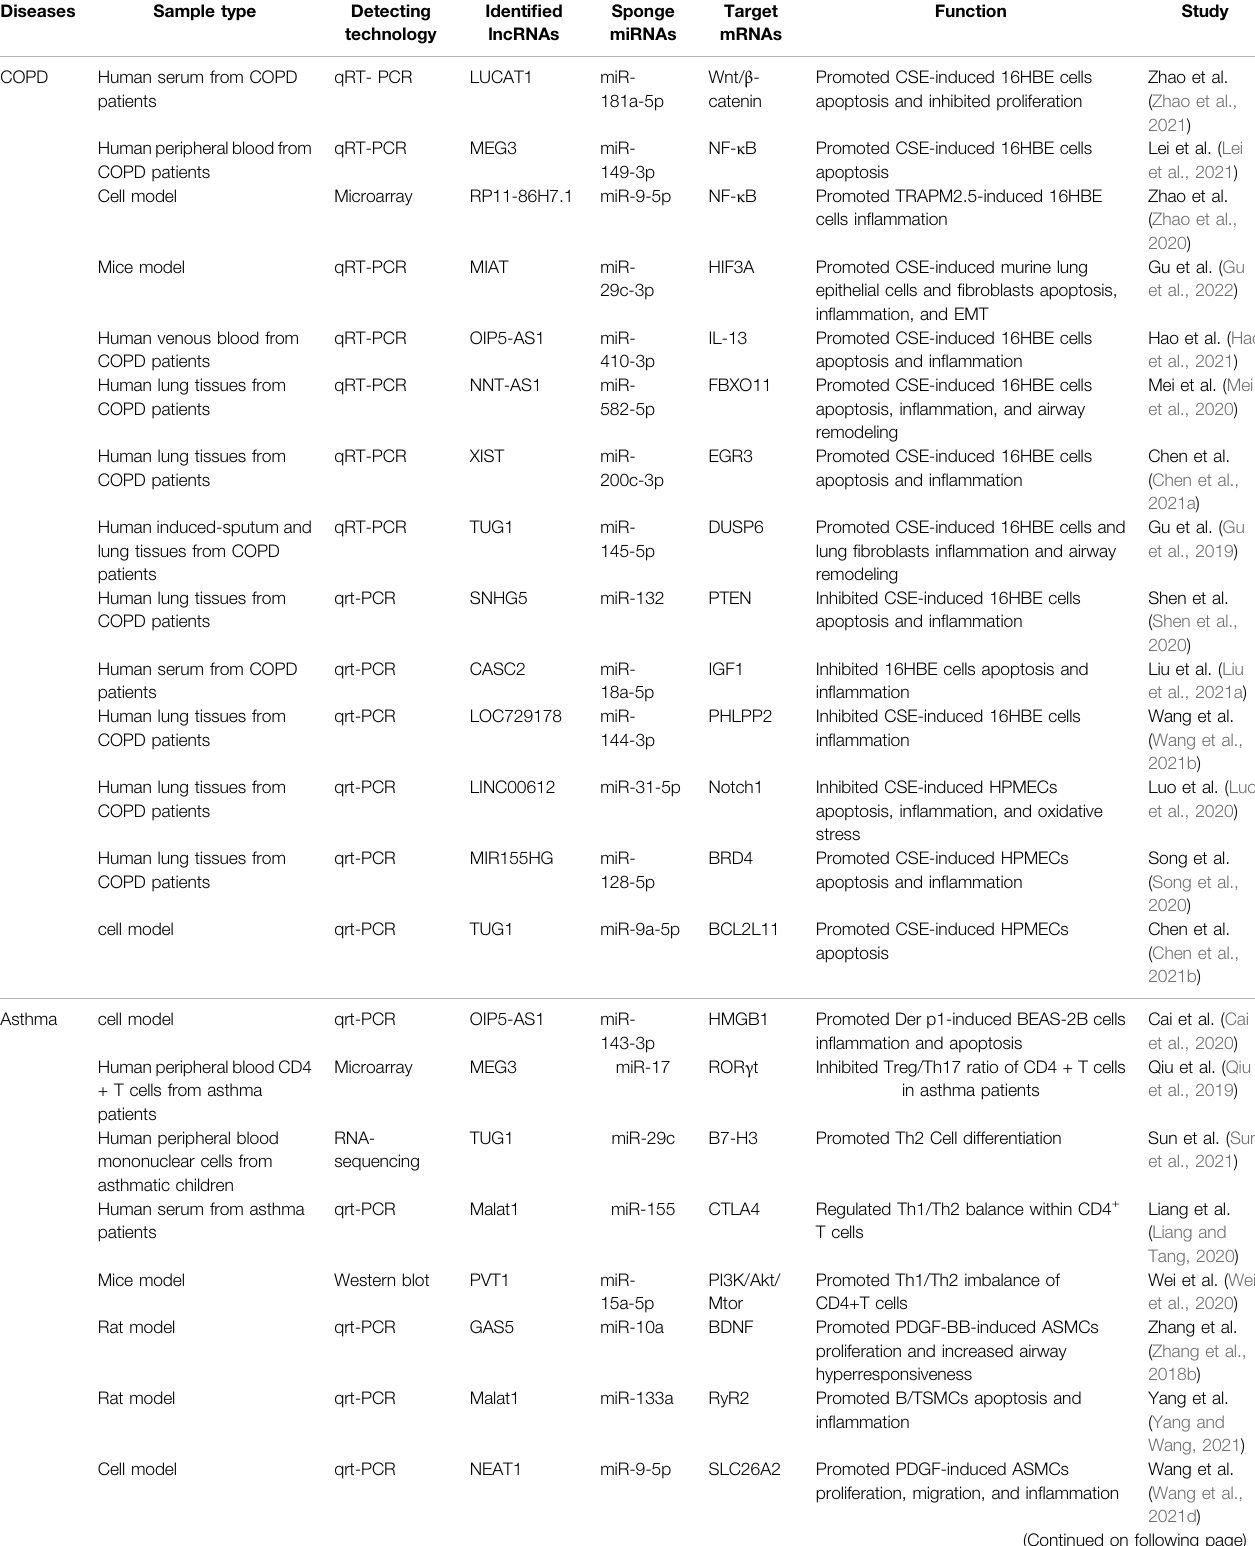
TABLE 1 | The crosstalk of lncRNA-miRNA-mRNA in COPD and asthma.